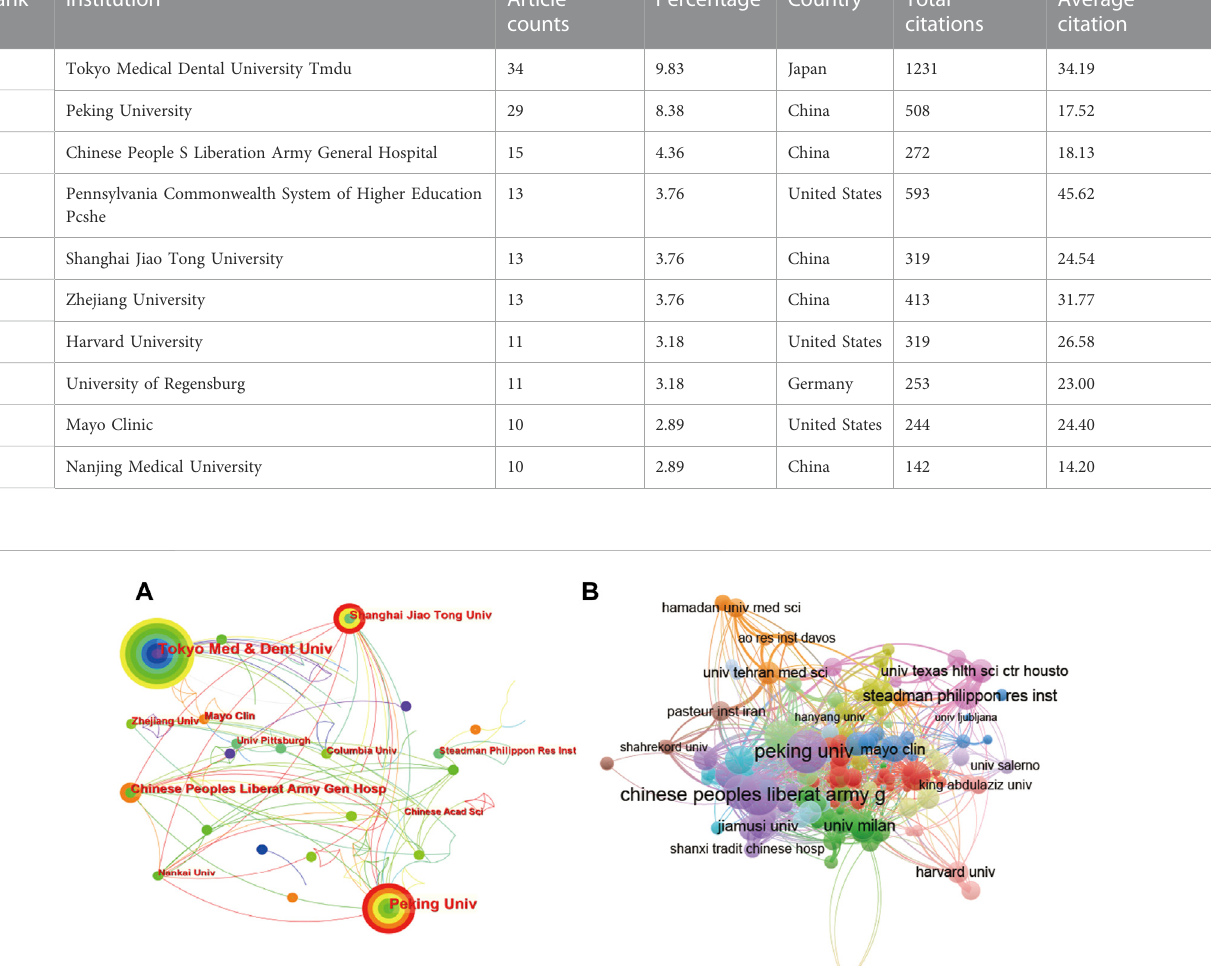
TABLE 2 The top 10 institutions published literature related to stem cells for meniscal regeneration. Rank